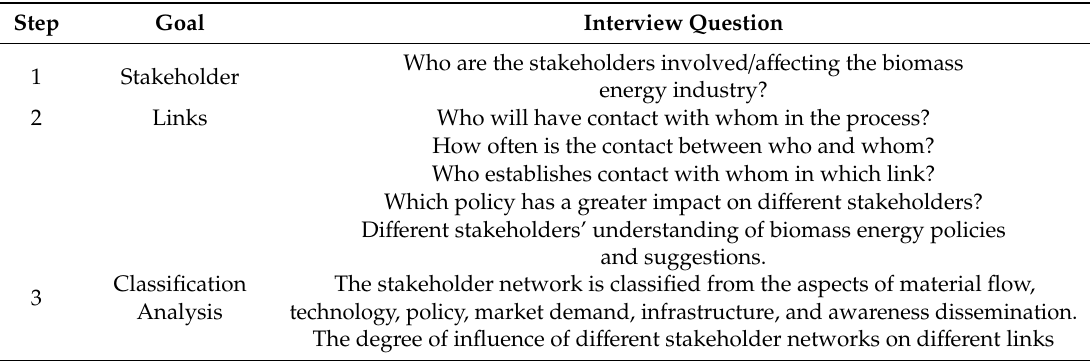
Table 1. Design of interview questionnaire for stakeholders in the biomass energy